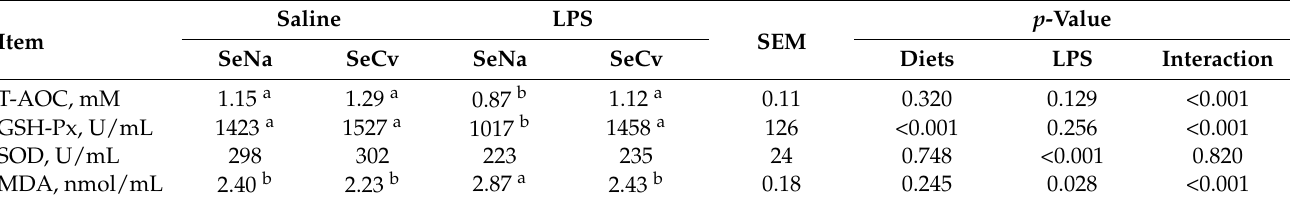
Table 2. Effect of Cardamine violifolia on plasma anti-oxidative capacity of broilers challenged and unchallenged intraperitoneally with LPS.